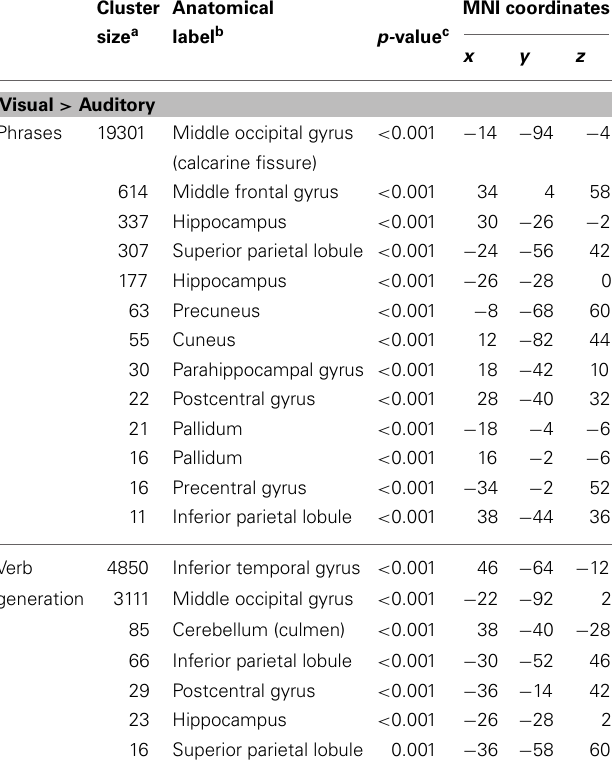
at the group level for both investigated language paradigms. All Table 1 | Significantly higher activated brain areas by visual compared to auditory presentation of the two language